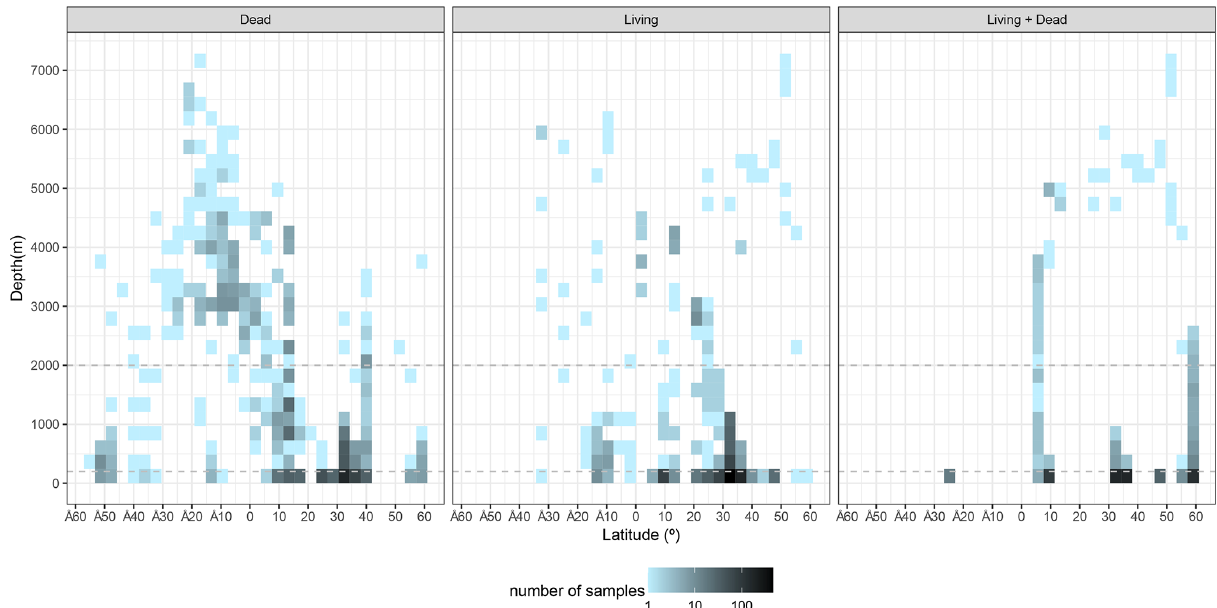
Figure 2. Distribution of samples with water depth and latitude. Horizontal dashed lines separate the neritic (0–200m), the bathyal (200– 2000m), and the abyssal ( > 2000m) zones following the bathymetric divisions of van Morkhoven et al. (1986). The graphs were elaborated with the “tidyverse” package (Wickham et al., 2019) using R version 4.2.1 (R Core Team, 2022).